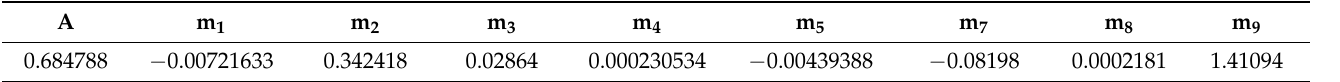
Table 2. Parameters of function (1) for the AZ31 magnesium alloy [33].